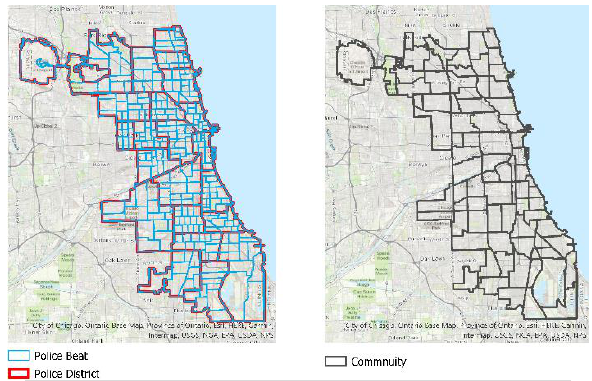
Figure 1. Chicago police district, police beat and community